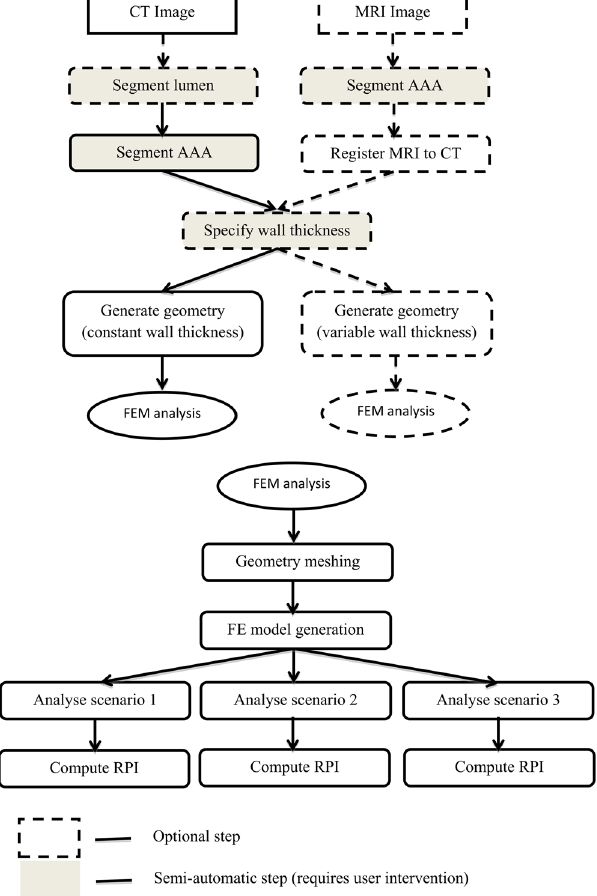
Figure 1. Diagram of the workflow. Only segmentation and wall thickness specification require user intervention; all other steps are automated. Multiple modelling scenarios are analysed (Scenario 1: pressure load on internal ILT wall; Scenario 2: no ILT included; scenario 3: ILT included and pressure load on internal AAA wall). MRI = magnetic resonance imaging, CT = computed tomography, FEM = finite element